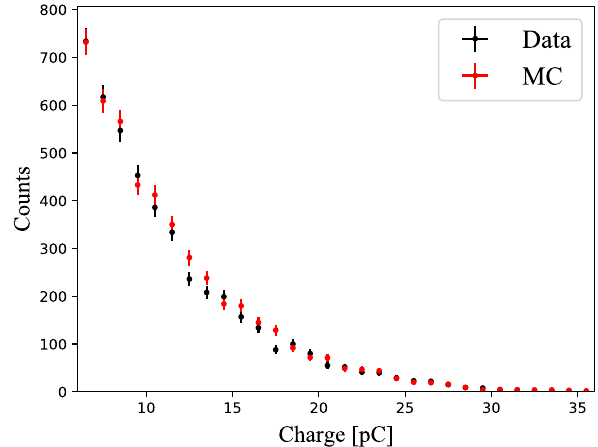
Fig. 5 An example log-normal fit to an SPE waveform from the LAPPD Table 1 Results of the pulse-shape calibration used as input to the MC, for waveforms from the LAPPD and trigger PMT Parameter Mean Std. dev.